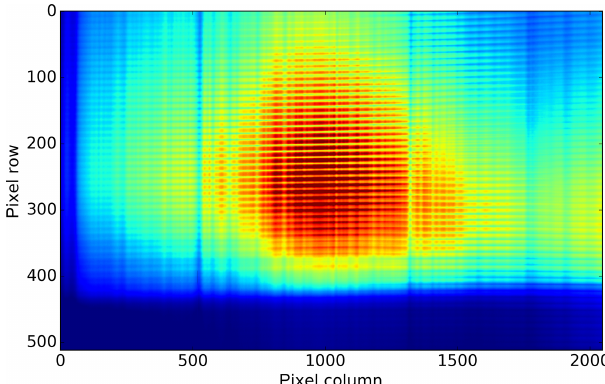
Figure 2. Typical CCD image as recorded during CINDI-2. The x axis is the spectral direction while the y axis represents the view- ing elevation. The illumination is color-coded (blue represents small illumination and red represents large illumination). The x axis cov- ers 394.5–536.4nm, i.e., for the DOAS fit of 425–490nm only the inner part is used. On the y axis, single fibers observing different elevation angles are separated and distinguishable. Fraunhofer lines are visible in each fiber at the same spectral position. The horizon causes a sharp transition between illuminated and nonilluminated fibers in the lower part of the